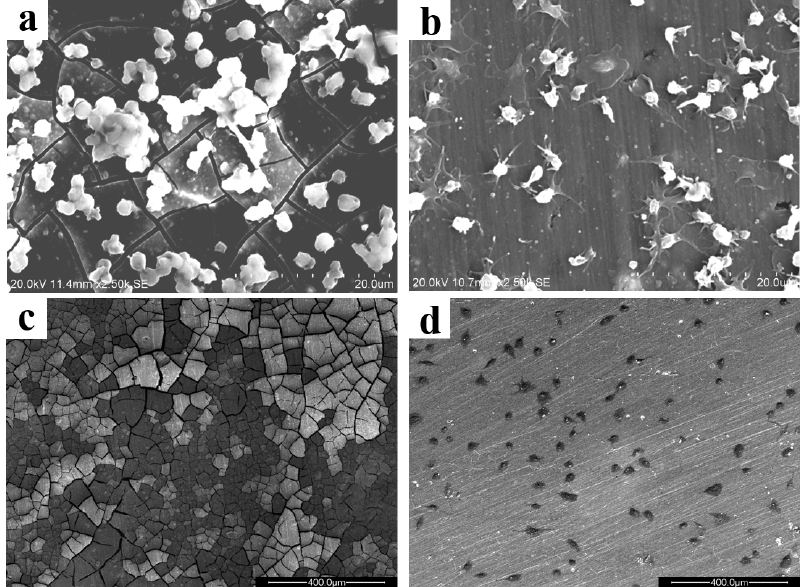
Figure 8. Morphology of adherent platelets on ( a ) MgZn substrate, ( b ) MgZn–0.2 F sample; and adherent Ea.hy926 cells on ( c ) MgZn substrate, ( d ) MgZn–0.2 F